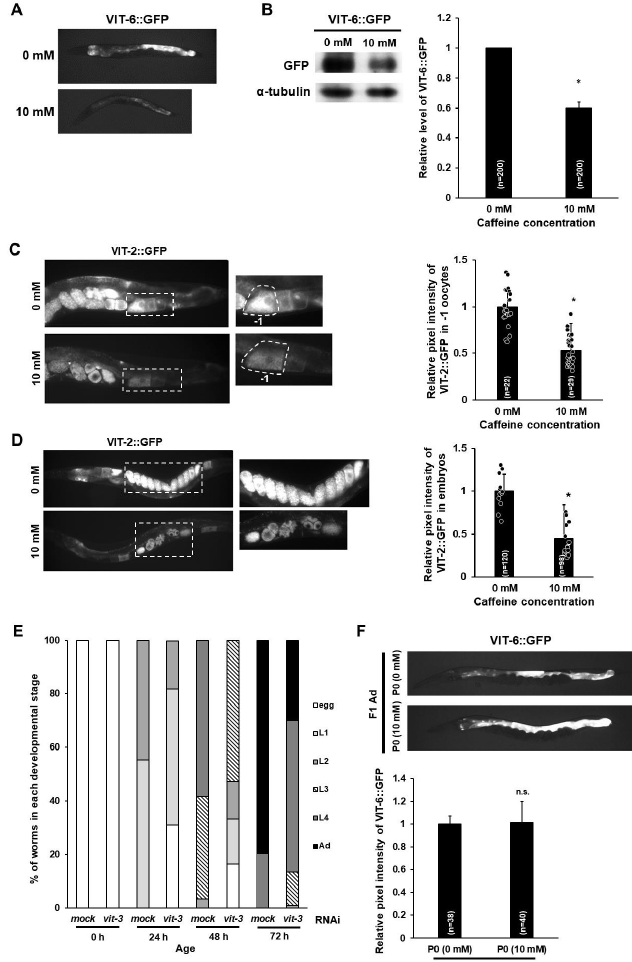
Figure 4. Maternal ca ff eine intake reduces vitellogenin (yolk proteins) in Caenorhabditis elegans . ( A ) VIT-6::GFP transgenic animals synchronized at the L4-stage were exposed to ca ff eine for 24 h at 20 ◦ C. VIT-6::GFP expresses in the intestine. The reduced level of VIT-6::GFP in the intestine was observed in ca ff eine-ingested mothers. ( B ) Western blot analysis of VIT-6::GFP protein levels in ca ff eine-free diet mother (0 mM) and ca ff eine-ingested mother (10 mM). Respective GFP band intensities were normalized against those of α -tubulin in the same lane. Then the normalized GFP band intensity was converted to a relative value compared to the normalized GFP band intensity of 0 mM, as shown in the right graph with mean ± SD values. These GFP band intensity values were obtained from three independent Western blot analyses. Statistical significance was calculated using Student’s t -test. * p < 0.05. ( C , D ) VIT-2::GFP transgenic animals synchronized at the L4-stage were exposed to ca ff eine for 24 h at 20 ◦ C. The ca ff eine-ingested mother showed a reduced level of VIT-2::GFP intensity in oocytes and embryos, as shown in the right graph with mean ± SD values. ( E ) Synchronized L4-stage animals ( n = 30) of wild-type were treated with RNA interference (RNAi) of vit-3 gene for 24 h and recovered to OP50-seeded nematode growth medium (NGM) plates for 24 h. The embryos produced by P0 mothers were transferred to respective NGM plates and further cultured at 20 ◦ C. The developmental stage of each individual in the progenies was determined based on its size and stage-specific morphological characteristics (see Section 2 for details) during development by either the vit-3 RNAi-treated P0 mother (10 mM) or non-treated (mock) P0 mother (0 mM). ( F ) VIT-6::GFP transgenic animals synchronized at the L4-stage were exposed to ca ff eine for 24 h at 20 ◦ C. Then their F1 generation grew under the ca ff eine-free diet (0 mM) condition, and VIT-6::GFP transgenic F1 animals were observed at the adult stage. Statistical significance was calculated using Student’s t -test. n.s., p >